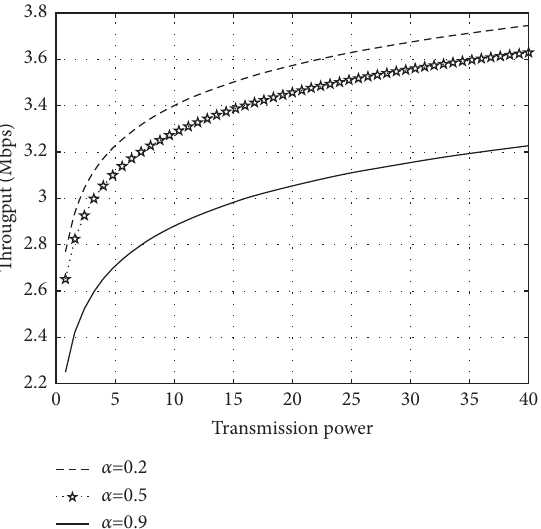
Figure 6: Throughput against transmission power.